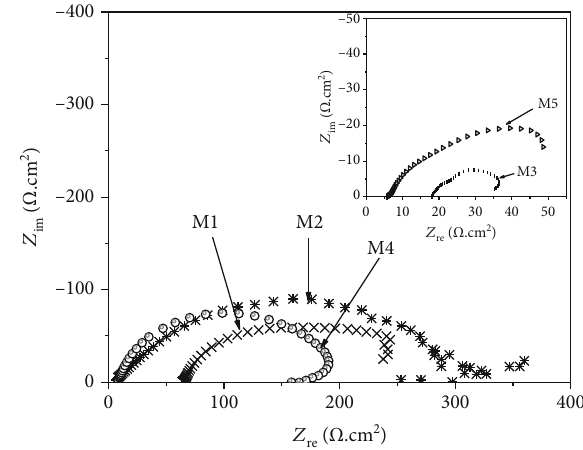
Figure 1: Nyquist plots for aluminum-based alloy doped with Mn and Co as cast, immersed in 3 M